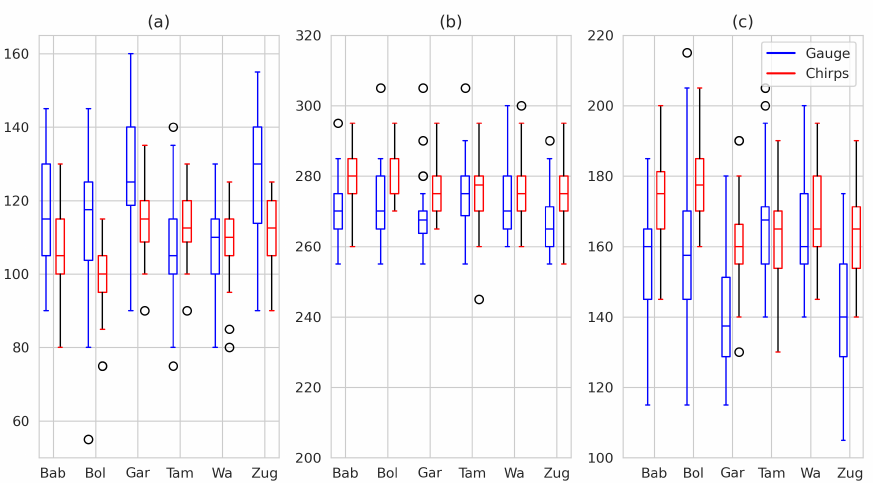
Figure 6. Variability (day of year) of rainfall onset ( a ), cessation ( b ) and the LGP ( c ) derived from CHIRPS-v2 (red) and gauge data (blue) at the location of the six stations in Northern Ghana from 1981 through 2016. Black circles indicate outliers. Station locations are shown in Figure 1 and their labels are Babile (Bab), Bole (Bol), Garu (Gar), Tamale (Tam), Wa (Wa) and Zug (Zuarungu).